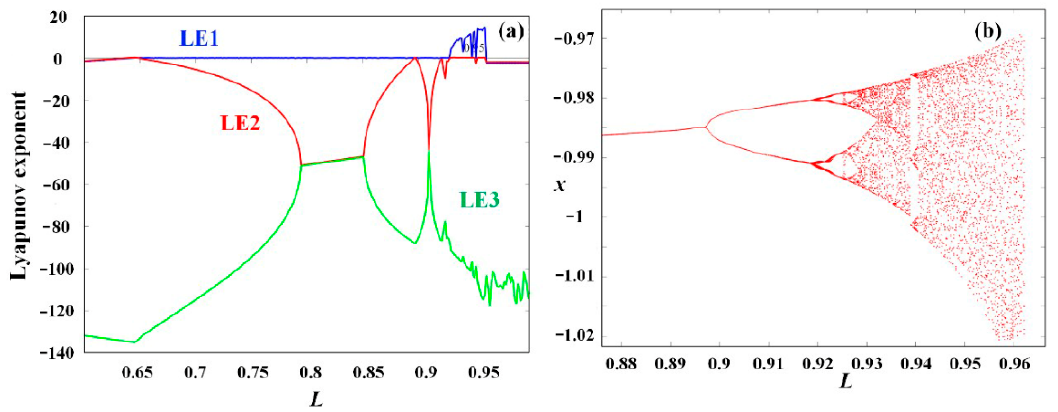
Figure 21. ( a ) Lyapunov exponent spectrum and ( b ) bifurcation of system with the inductance L (if C = 26 μ F).